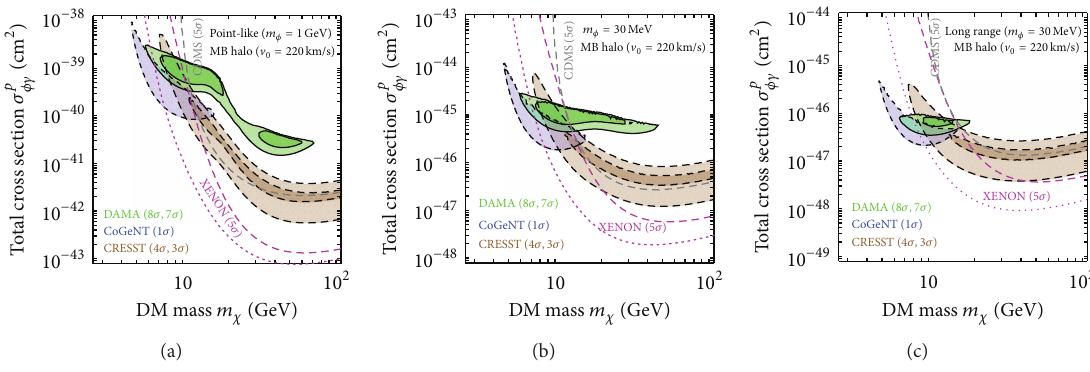
Figure 3: Normalized total cross section as a function of the dark matter mass . For a better visualization of the transition from the contact to the long range regime, we have fixed three values of the dark photon mass; namely, 𝑚 𝜙 = 1 GeV (a), 𝑚 𝜙 = 30 MeV (b), and 𝑚 𝜙 = 0 (c). In all plots we show the regions where the absence of annual modulation can be rejected at 7 𝜎 CL (outer region) and 8 𝜎 CL (inner region) for DAMA (solid green contours) and 1 𝜎 CL for CoGeNT (solid green contours). For CRESST - II (solid green contours) the absence of an excess is instead excluded at 3 𝜎 CL (outer region) and 4 𝜎 CL (inner region). Constraints, derived at 5 𝜎 CL, are shown as dashed gray lines for CDMS - Ge and magenta lines for XENON100 . These results have been presented in [24,